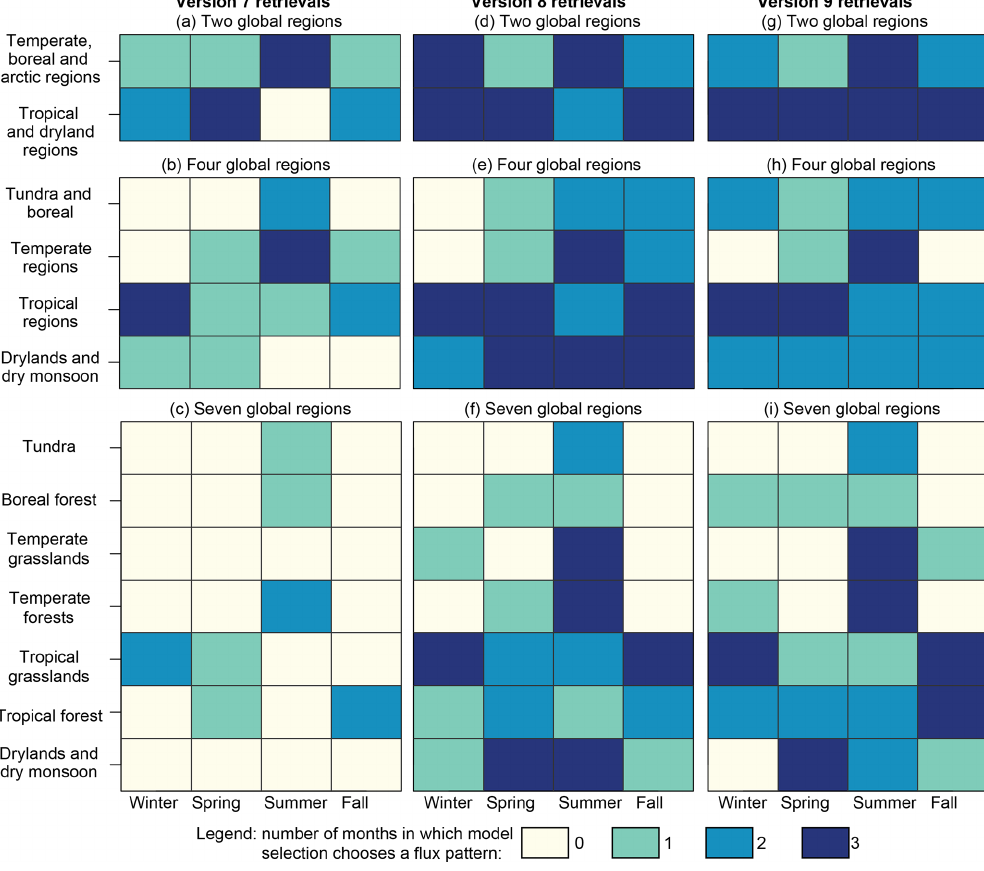
Figure 3. Results of the model selection experiments using versions 7, 8, and 9 of the OCO-2 observations. Versions 8 and 9 provide a much stronger constraint on biospheric CO 2 fluxes than version 7. The top row (a, d, g) displays the results of the experiments with two global regions, the second row (b, e, h) with four global regions, and the third row (c, f, i) with seven global regions. Each box is color- coded based upon the number of months in which at least one biospheric flux model is chosen using model selection. Dark colors indicate a strong constraint on monthly CO 2 fluxes while light colors indicate a weak constraint. Note that these experiments include nadir-, target-, glint-mode observations. In addition, version 7 results are the same as those in Miller et al.